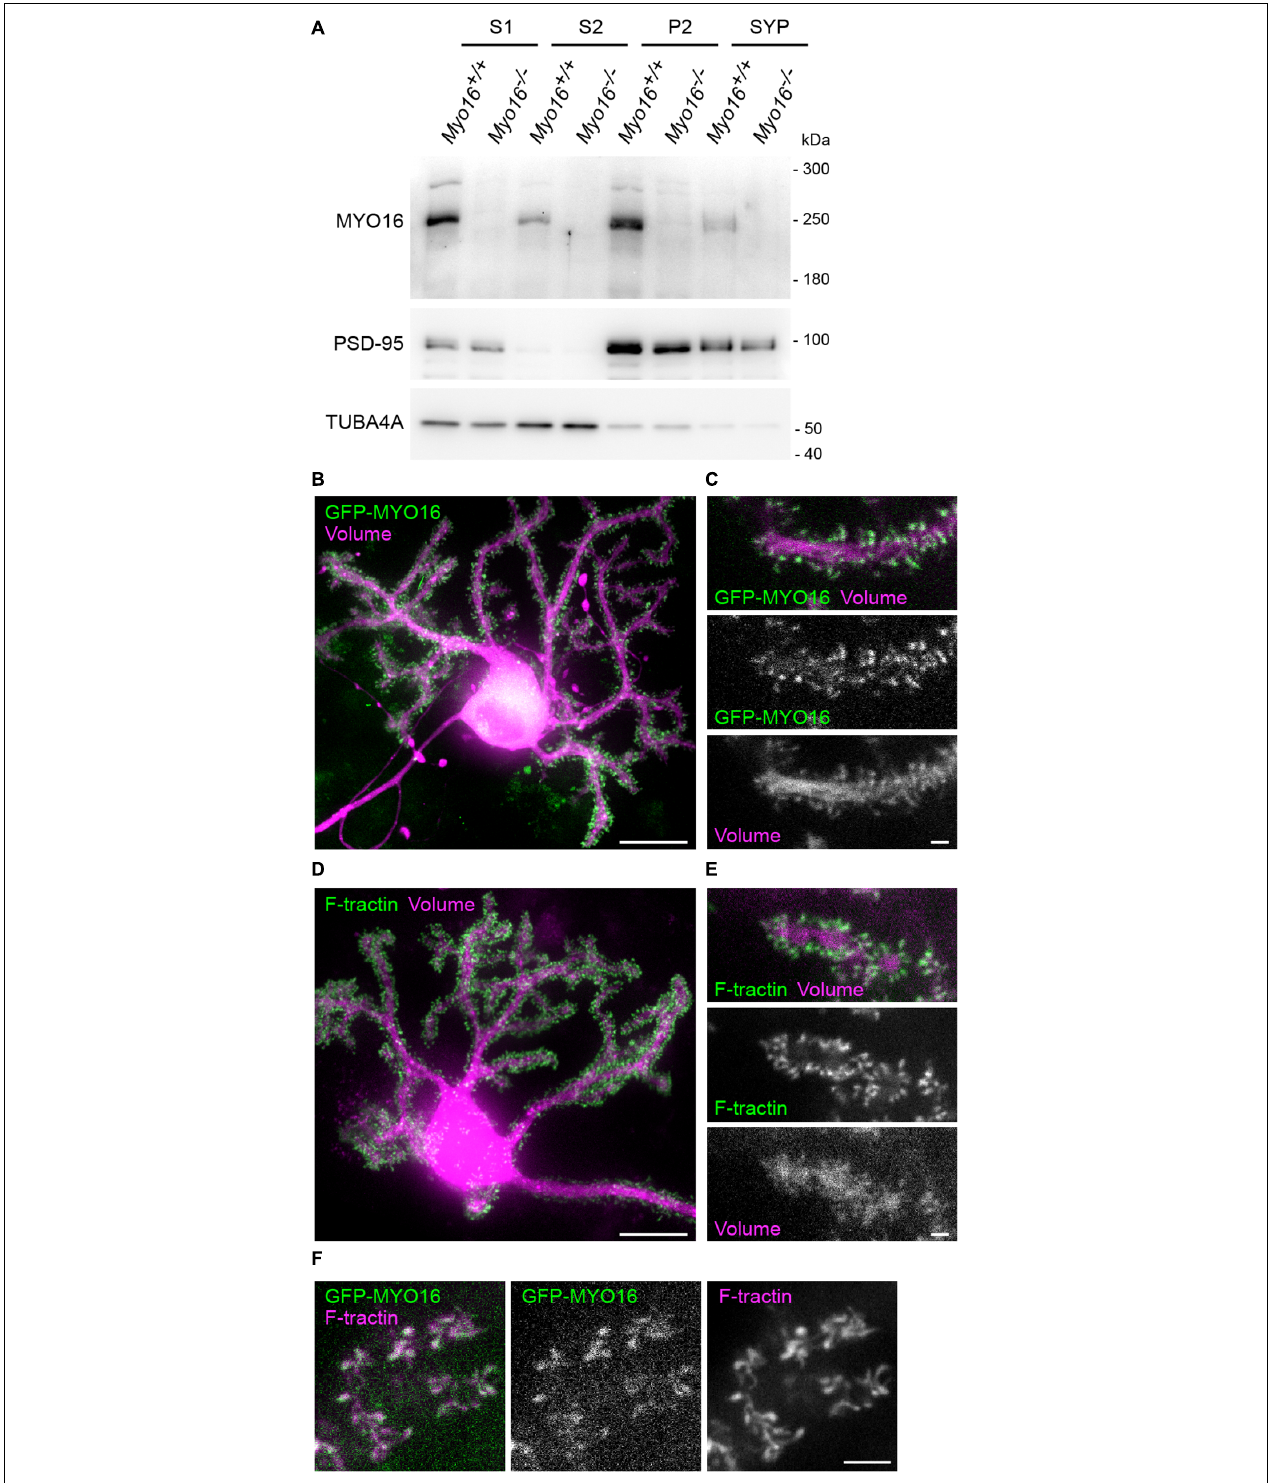
FIGURE 2 | MYO16 localizes to the synaptosomal fraction and to Purkinje cell dendritic spines. (A) Cerebellar extracts of 3–4 week old Myo16 + / + and Myo16 em 2 knockout mice ( Myo16 − / − ) were subjected to subcellular fractionation. S1, S2, P2, and SYP fractions were analyzed by Western blotting using antibodies against MYO16 (pre-adsorbed), PSD-95 (marker for membrane/synaptosomes), and alpha-Tubulin 4A (TUBA4A; marker for loss of cytosolic components). Note that specific MYO16 signal is present in P2 and SYP fractions ( n = 3 experiments). (B) GFP-tagged myosin XVI heavy chain accumulates within the dendritic spines of